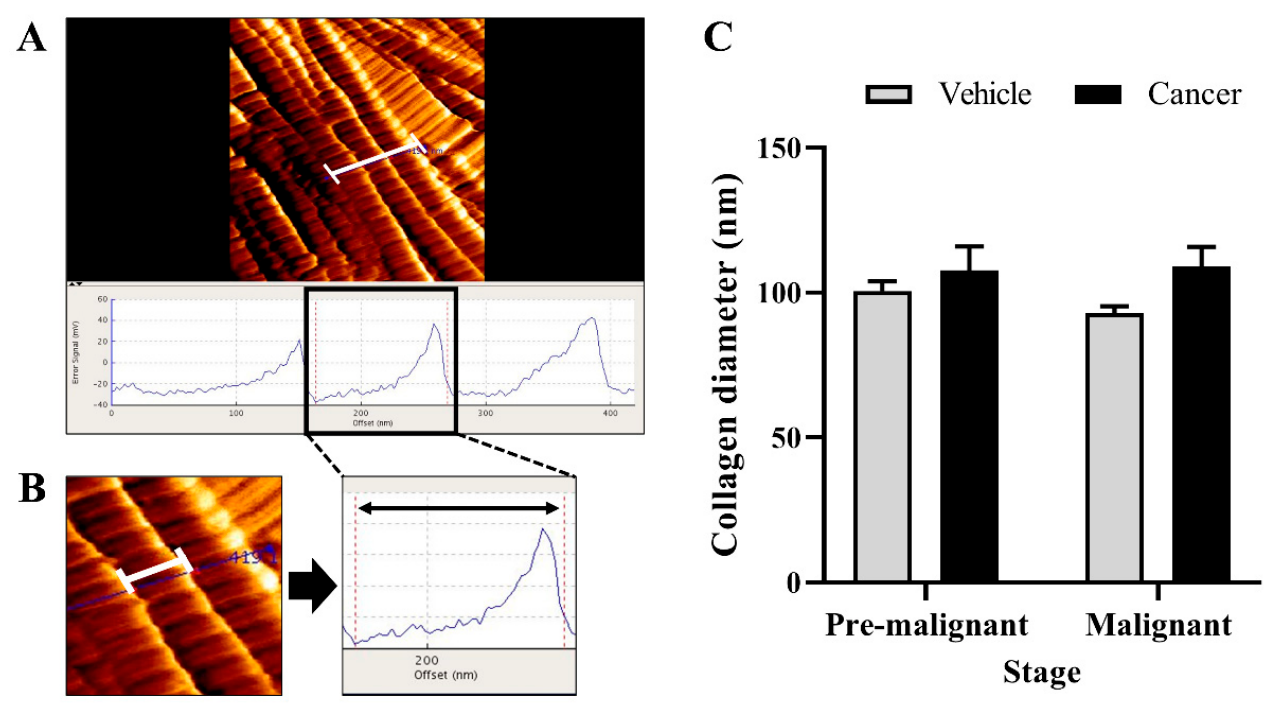
Figure 3. ( A ) The collagen diameter measurement for three collagen fibrils with their respective micrograph scale bar. ( B ) The magnified collagen diameter measurement for one collagen fibril with their respective micrograph scale bar. The double-sided arrow shows the length of one collagen diameter measured. ( C ) The bar chart of collagen diameter (nm) at the bronchial area of the Vehicle and Cancer groups from both stages of carcinogenesis. Data are presented as mean ± SEM.